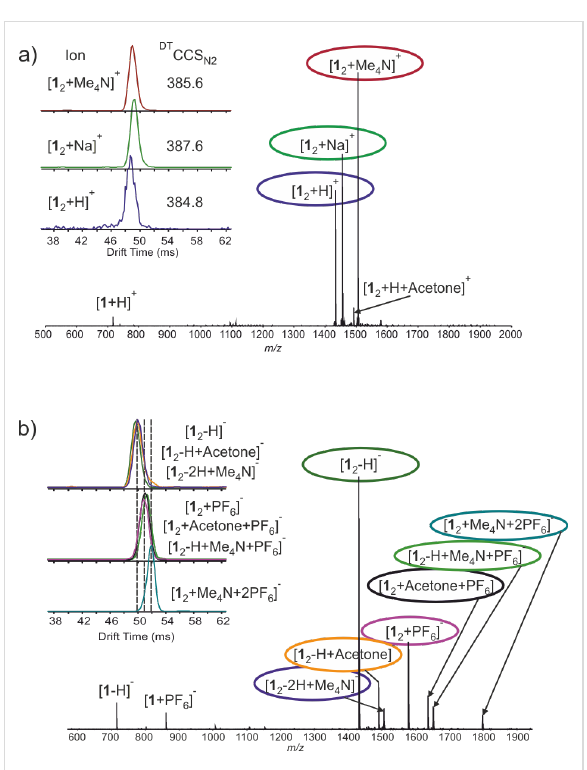
Figure 1: Spectra of 1 + Me 4 NPF 6 1:3 in acetone in a) (+)ESI-MS and b) ( − )ESI-MS. Insets showing arrival time distributions for selected ions. Identical drift times demonstrate the same structural diameters and CCS values for these ions. Separate arrival time distributions (ATDs) for ions in Figure 1b are shown in Supporting Information File 1 (Figure S2). m / z values, mass accuracies and CCS values are listed in Table S1 (Supporting Information File